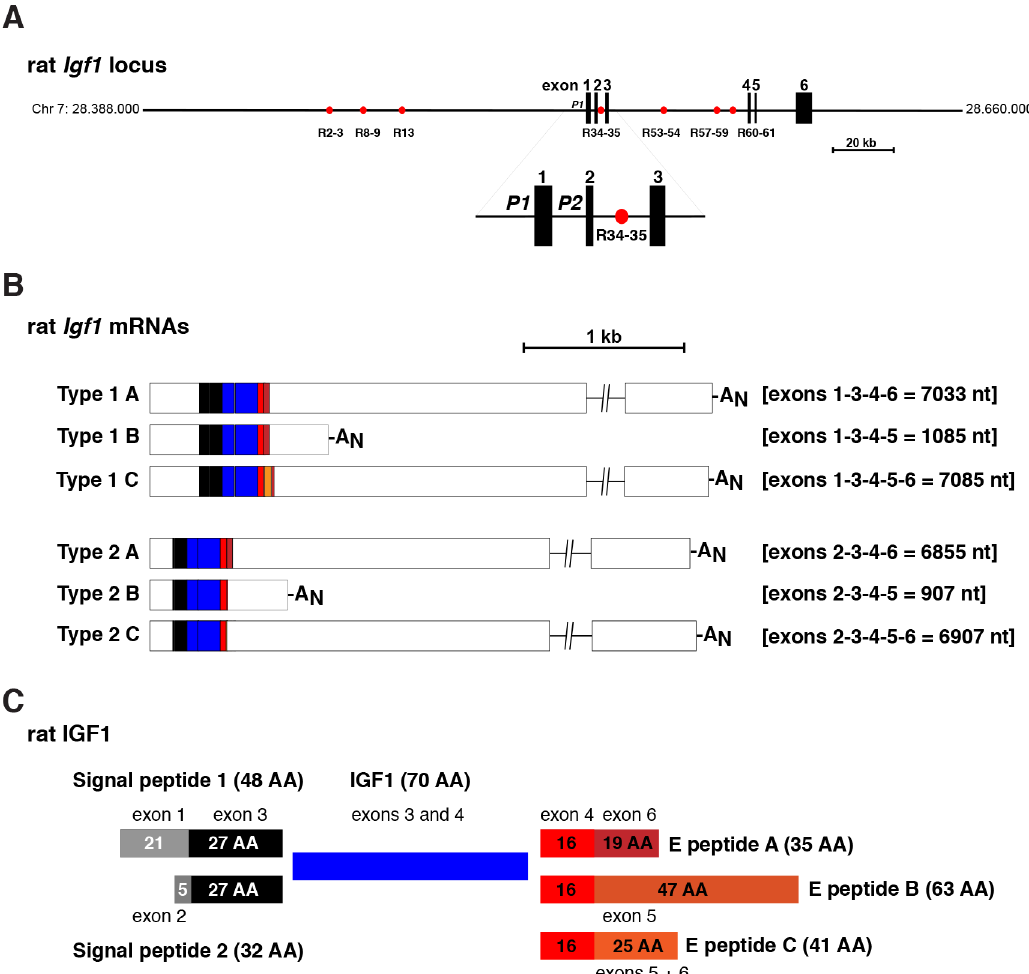
Fig 1. Organization of the rat Igf1 gene and mRNAs. A . Map of the rat Igf1 locus with chromosomalcoordinates. Exons are depictedas boxes, and introns and flanking DNA as horizontallines. A scale bar is shown. The enlargement below the main map illustrates the two Igf1 promoters, P1 and P2, and exons 1–3. The red circles depict previously identifiedlocationsfor GH-induciblebindingsites for the Stat5b transcriptionfactor. B . Diagramof the six major classes of rat Igf1 mRNAs. Type 1 containsexon 1 (transcribed by Igf 1 promoter1), and Type 2 encodes exon 2 (transcribedby promoter 2). The letters A, B and C indicatetranscripts that containalternativelyprocessedexon 6, exon 5, or exons 5 and 6, respectively.The averagelength of each mRNA class is indicatedin nucleotides (nt). A N representsthe polyadenylic acid tail at the 3’ end of mRNAs. C . Diagramof rat IGF1 protein precursors, showingthe derivationof each segment from different Igf1 exons. Mature, 70-aminoacid IGF1 (center) is found within all precursors;signal peptides 1 and 2 (left), and E peptides A, B and C (right), are alternativelyencodedin part by different Igf1 mRNAs.